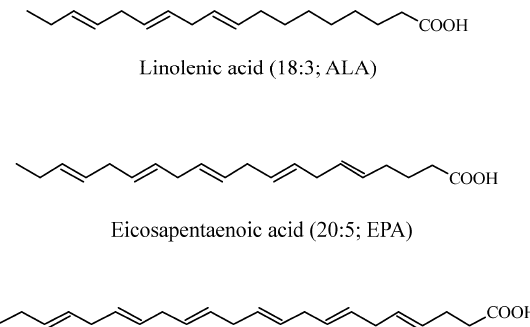
Figure 2. Main fatty acids of the omega-3 polyunsaturated fatty acids (PUFA) group.